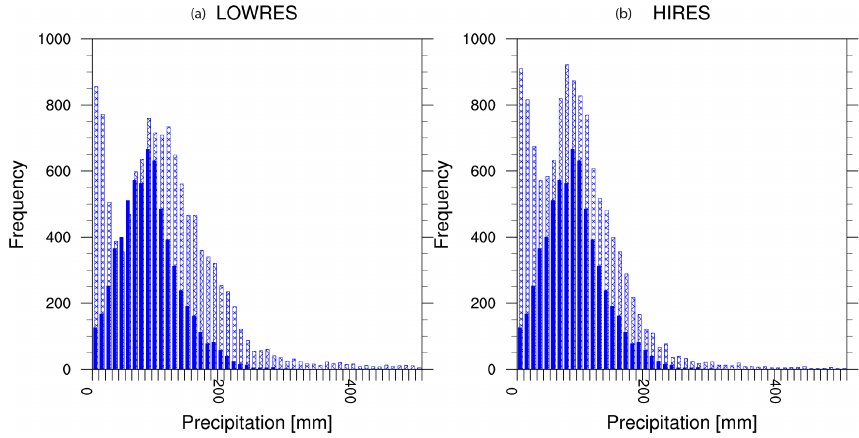
Figure 19. Histogram of the 2-month accumulated precipitation over Europe using the E-OBS data set. The filled blue bars denote the observation data set and the cross-hatched bars denote the HIRES (a) and LOWRES (b) simulation data.